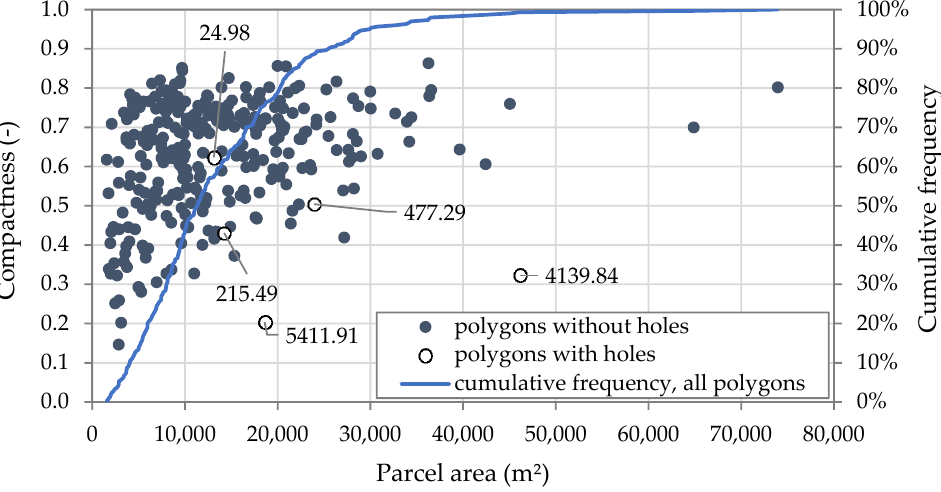
Figure 7. Compactness in relation to the parcel area for all geometries of land parcels with and without holes (numbers in diagram define the area of holes); cumulative frequency analysis of the shape area for land parcel geometries (green line); data source: [40].